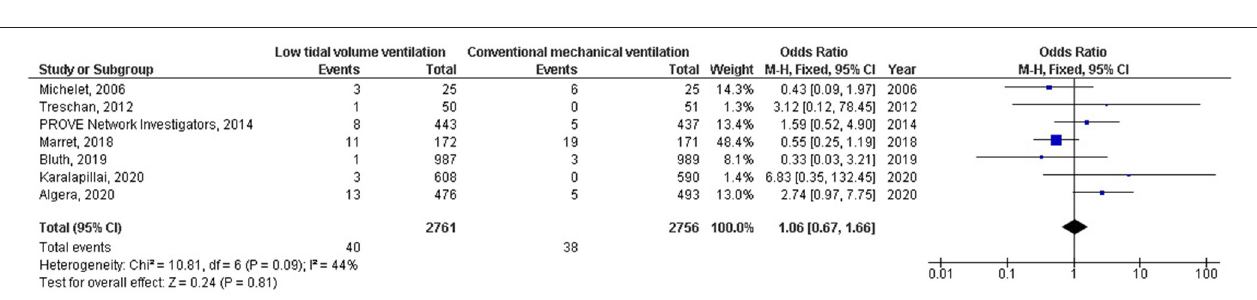
FIGURE 6 | Forest plot of the low tidal volumes strategy vs. conventional mechanical ventilation in subjects undergoing surgery on aspiration pneumonitis.